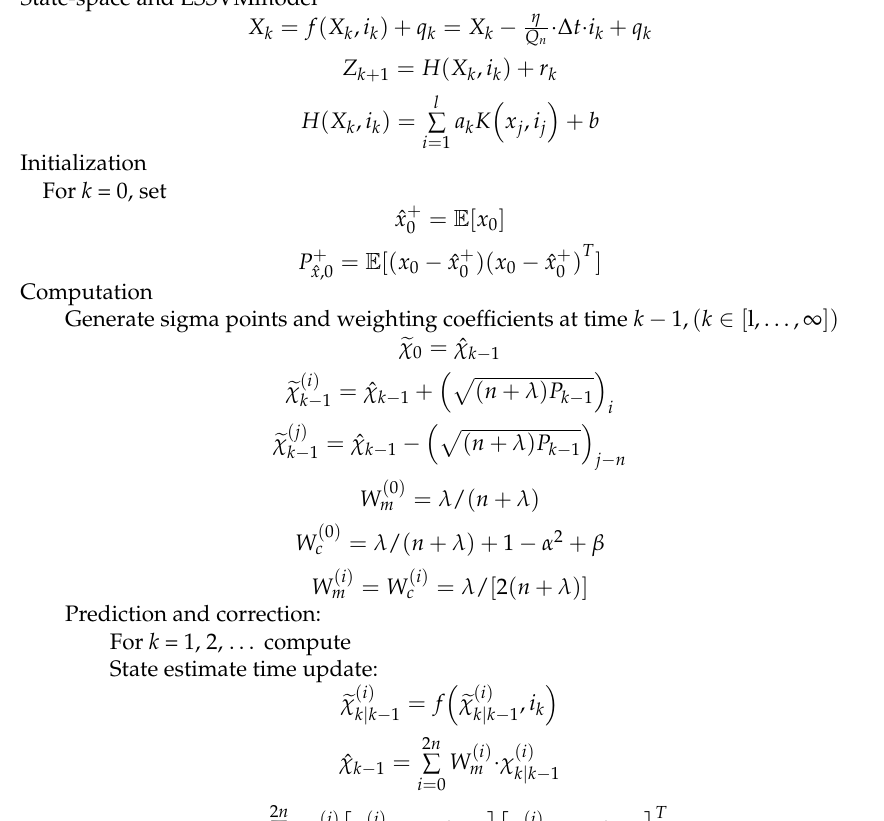
Table 11. Summary of AUKF-LSSVM for SOC estimation